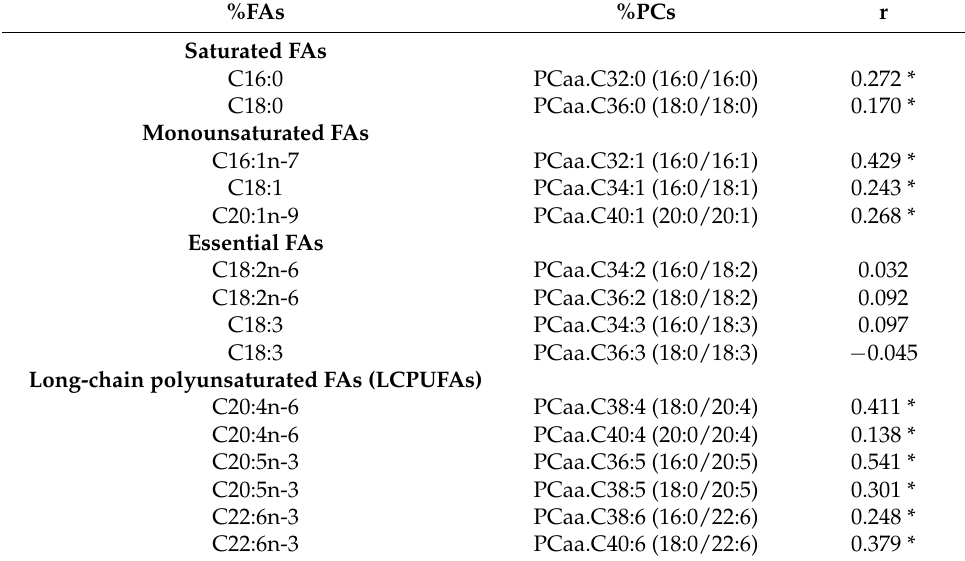
Table 3. Pearson’s correlation coefficients of %FAs and %PCs of total PLs ( n = 664).